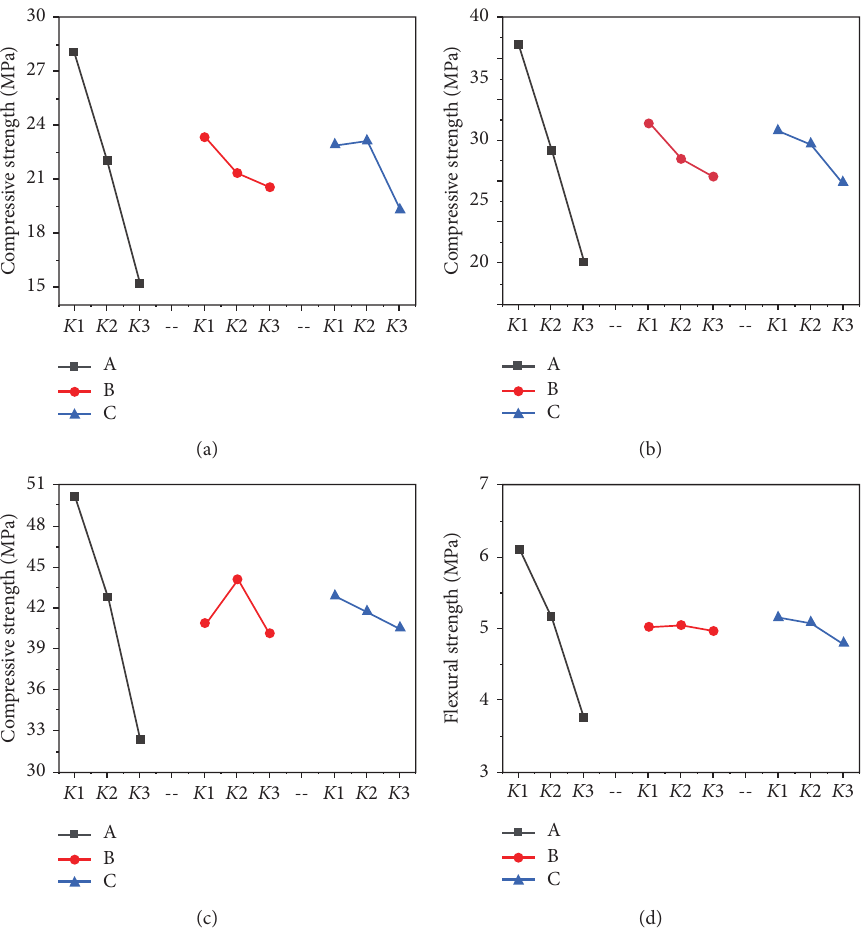
Figure 2: Impact of different levels: compressive strength at (a) 3d, (b) 7d, and (c) 28d; (d) flexural strength at 28d.